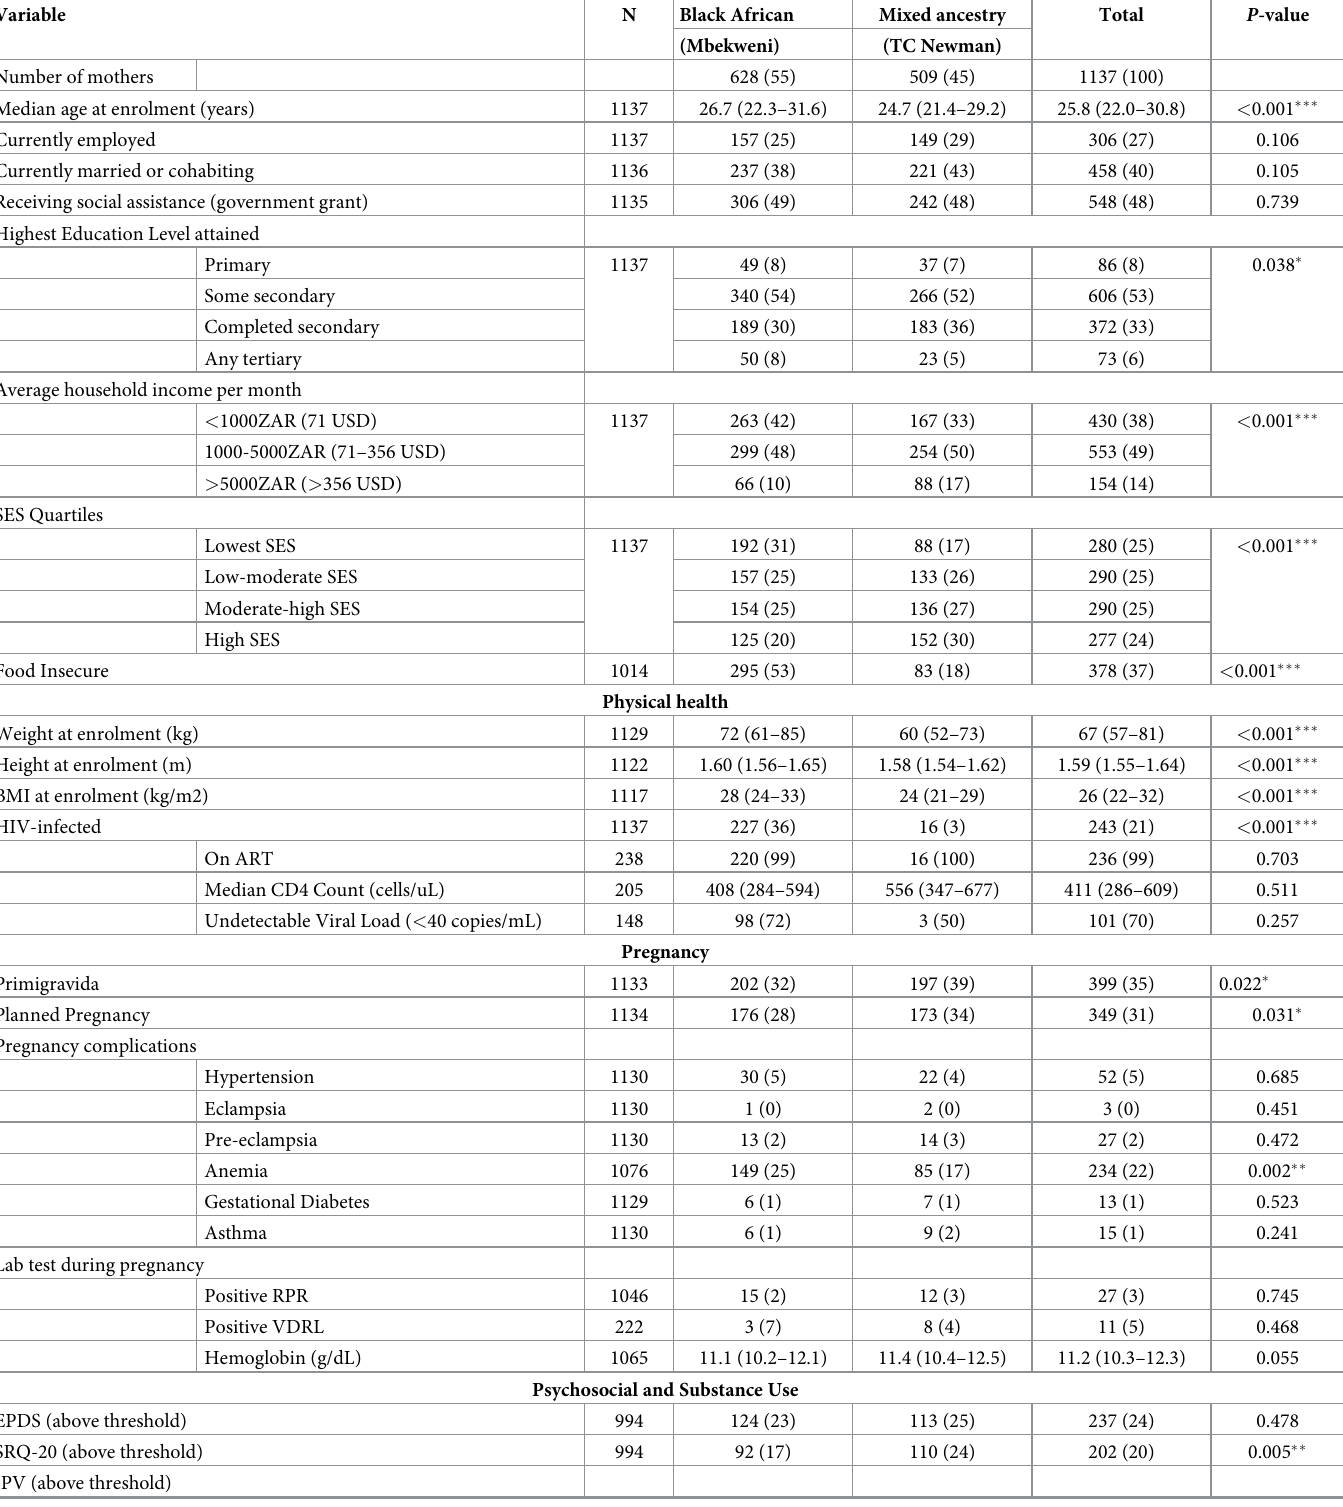
Table 1. Demographic, physical health and psychosocial characteristics of pregnant mothers enrolled in the birth cohort study (N =